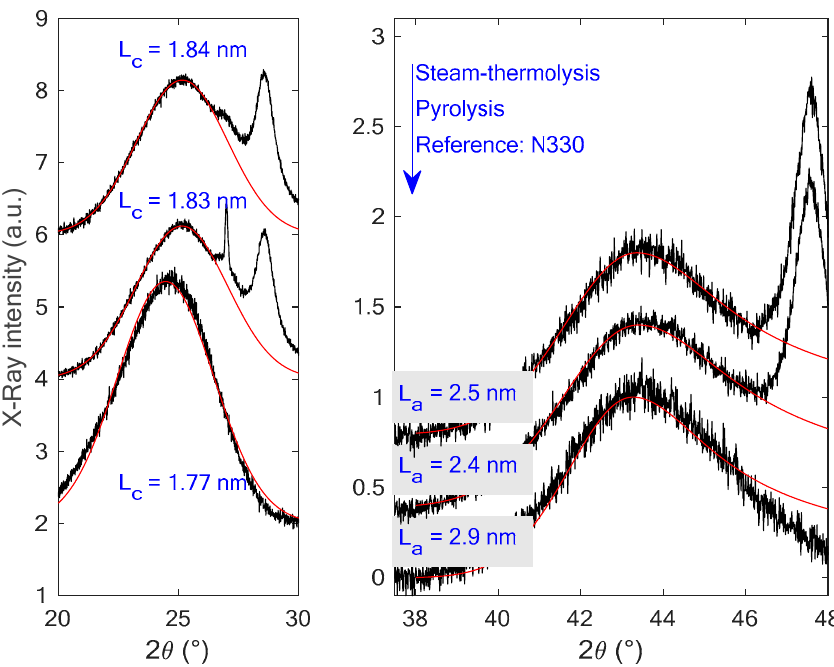
Figure 4. X-ray di ff ractogram (left: 002 region; right: 10 region) of the N330 carbon black before and after being incorporated into a model tire and then subjected to two recycling processes. The sharper and intense peaks seen on the right shoulder of both the 002 and the 10 peaks are due to leftovers of other phases involved in the tire fabrication. L a is the in-plane diameter of the crystallite size while L c is its height.